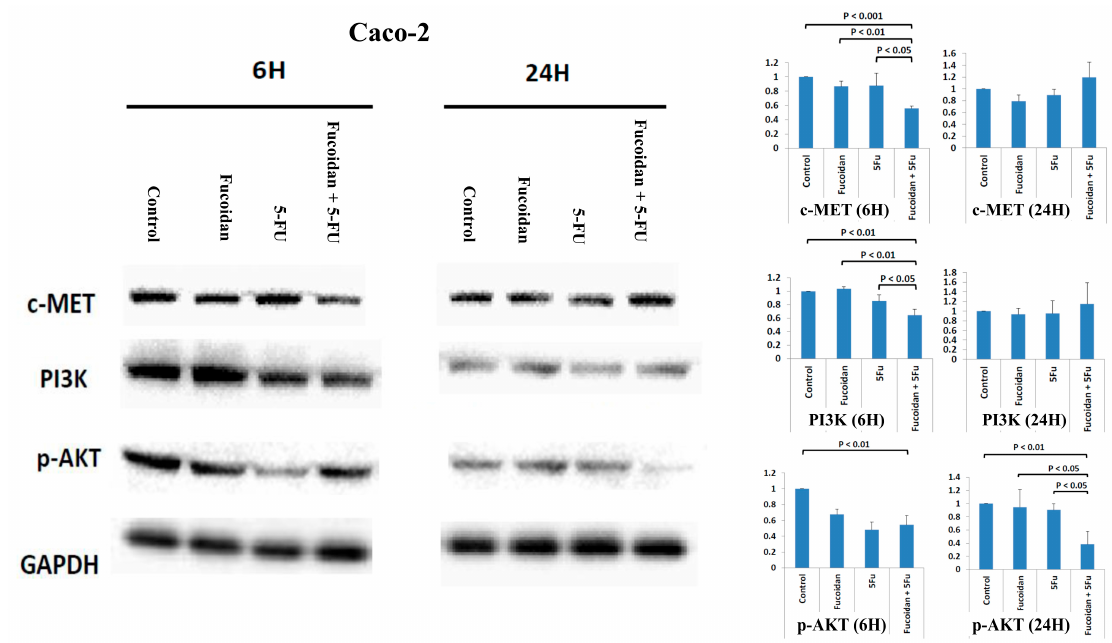
Figure 5. Expressions of c-MET protein, PI3K protein, and p-AKT protein in Caco-2 cells after treatment with LMWF, 5-FU, and combination of LMEF and 5-FU. Data are presented as the means of three independent experiments.